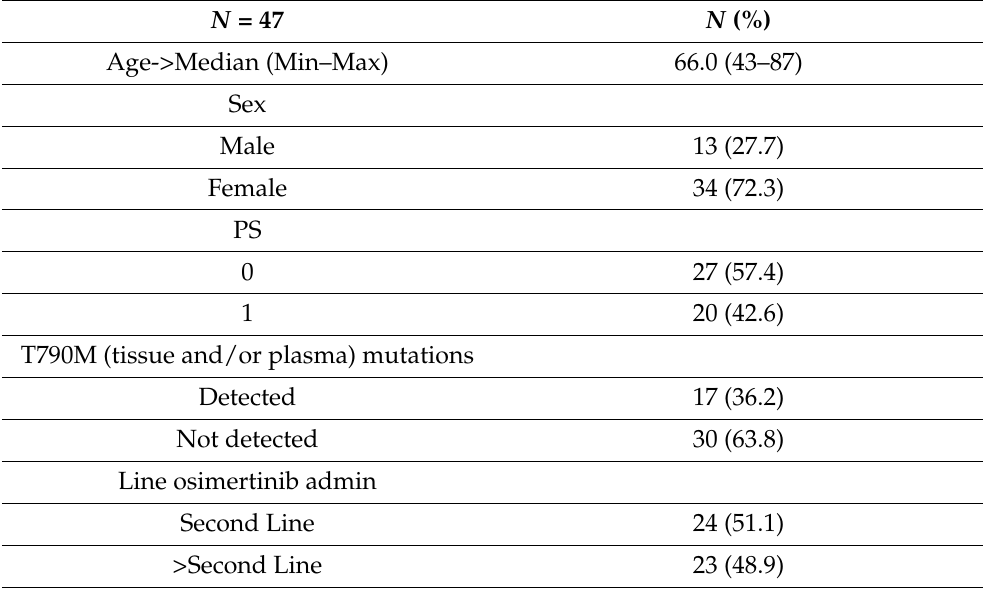
Table 1. Clinical characteristics and clinical